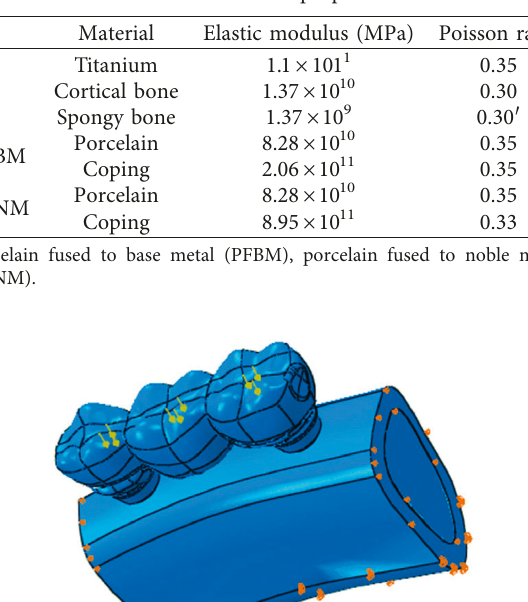
Table 2: Model meshing